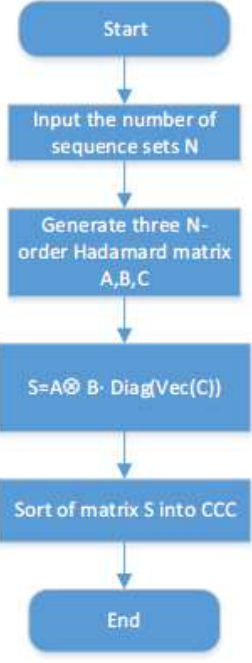
Figure 1. Generation method of { 𝑁,𝑁,𝑁 (cid:2870) } CCC. Table 1. {4, 4, 16} Complete Complementary Code.